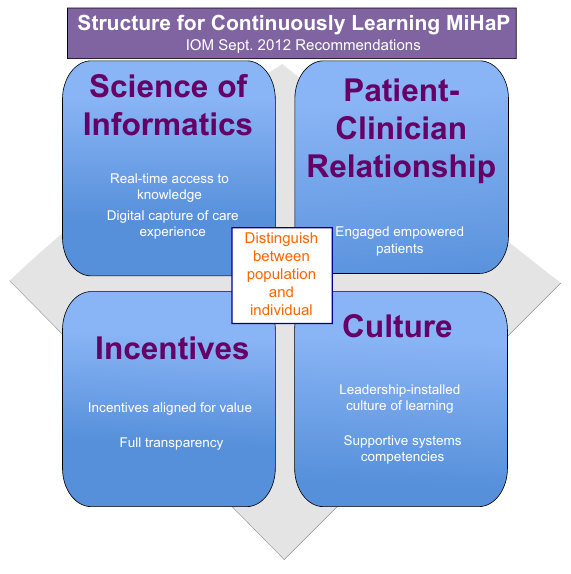
Figure 5. September 2012 IOM report recommended structure for continuous